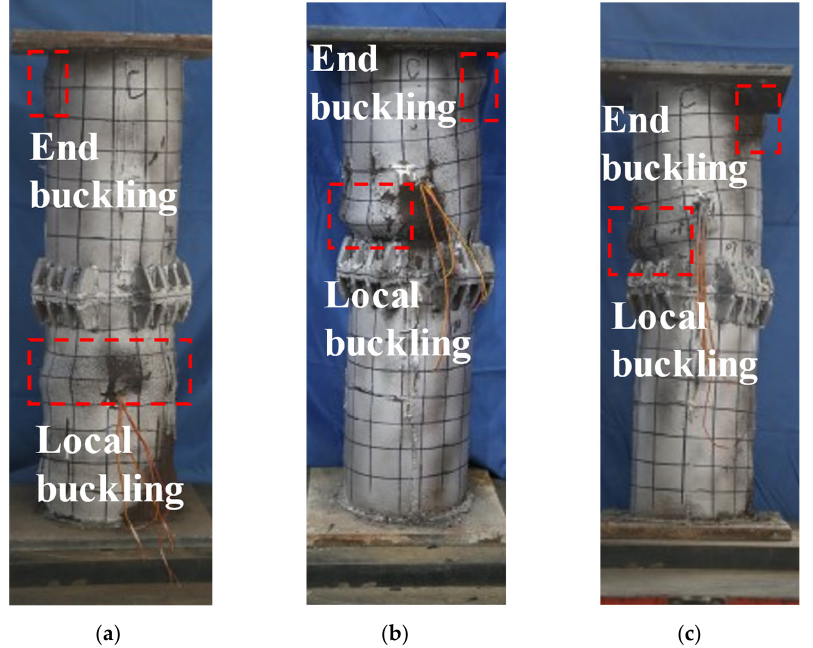
Figure 6. Failure modes of BWCFST short column specimens with interfacial gap of different  : ( a )  = 90°; ( b )  = 180°; ( c )  = 270°. θ : ( a ) θ = 90 ◦ ; ( b ) θ = 180 ◦ ; ( c ) θ = 270 ◦